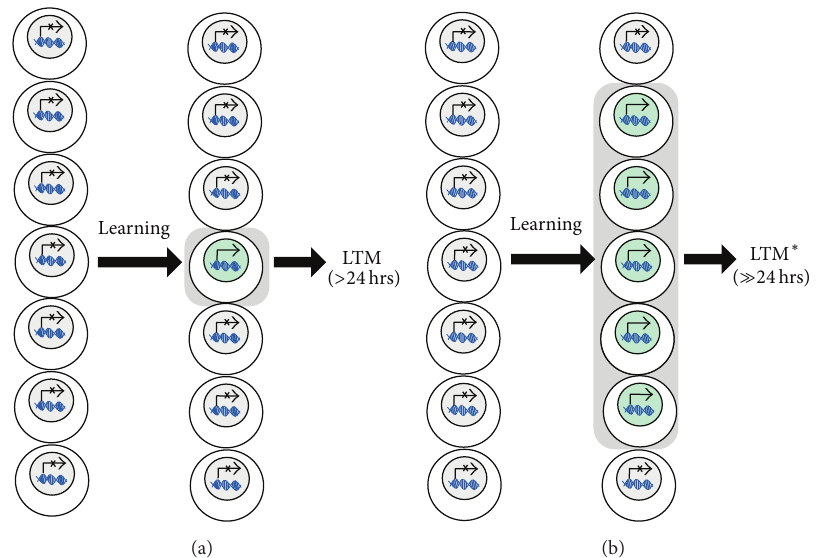
Figure 2: Long-term memory formation at a systems level. A schematic showing how a learning event can lead to two different outcomes for long-term memory when considering populations of neurons. (a) Learning processes can target a population of neurons that process task- dependent information during an experience. A typical threshold for long-term memory induction may only achieve gene expression events in a small number of neurons (here, only one out of the possible seven representatives of the population) that will undergo plasticity for memory consolidation and the formation of LTM. (b) If the threshold for memory induction is lower, gene expression events may occur in more neurons (here, five out of the seven neurons). The recruitment of more neurons with plasticity engaged could induce a larger network for memory that persists beyond typical long-term memory timescales. Notably, this conceptualization is applicable to any case of unusually strong and robust memories, including those induced by experimental manipulations (e.g., HDAC inhibition) and environmental influences such as stress, disease, drugs of abuse, or even therapeutic cognitive training paradigms. Conventions are as in Figure 1